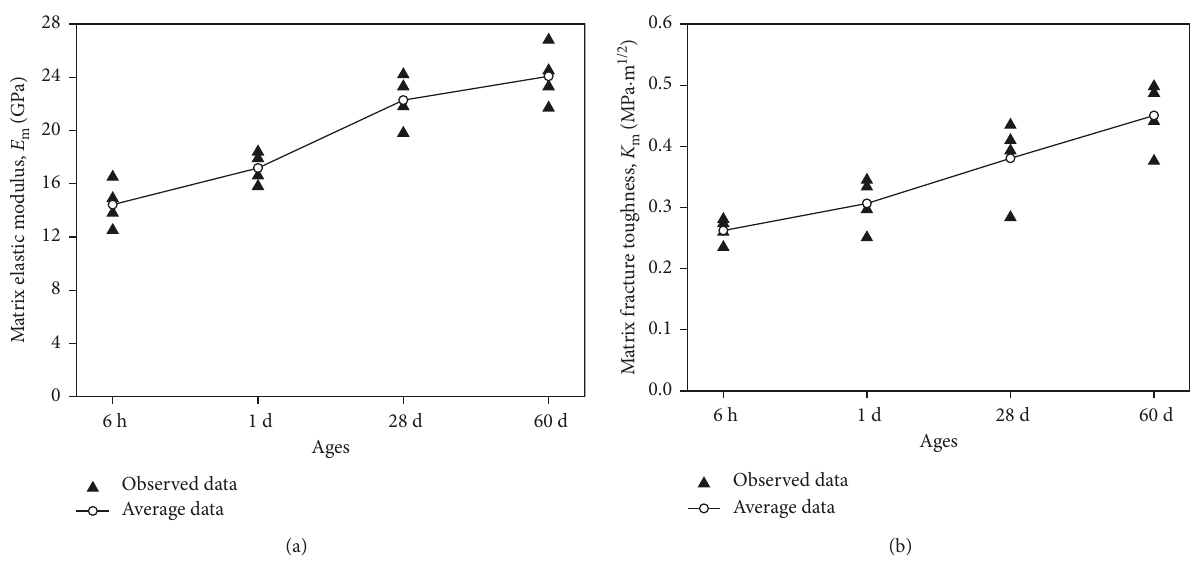
Figure 11: Influence of curing ages on matrix parameters: (a) E